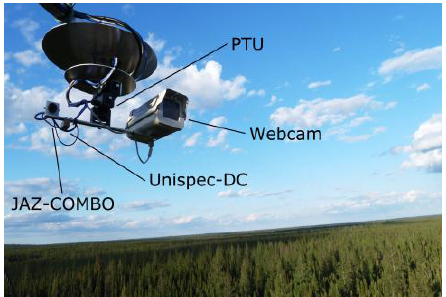
Figure 1. In situ photograph of the third generation Automated Multiangular SPectro-radiometer for Estimation of Canopy reflectance system (AMSPEC-III) taken at the Southern Old Black Spruce (SOBS) site.